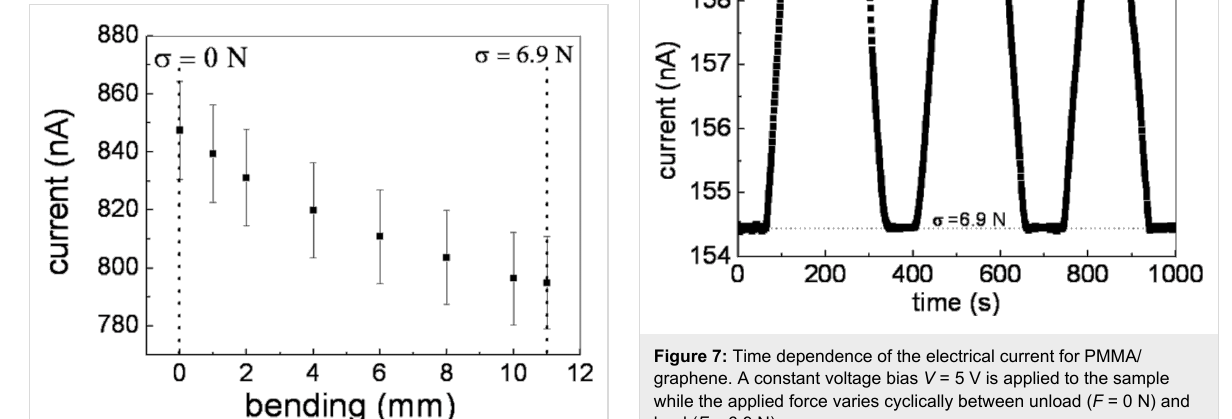
Noteworthy, the graphene/PMMA sample exhibits a good Ohmic behavior with a linear increase in electrical resistance to value of about 0.3 M Ω upon application of load up to F = 6.9 N.